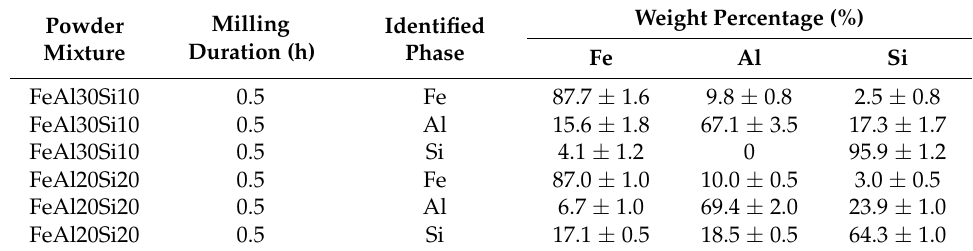
Figure 6. The SEM micrographs of the FeAl20Si20 alloy after: ( a ) 0.5 h, ( b ) 1 h, ( c ) 2 h, ( d ) 4 h of MA. Table 5. Average chemical composition of the phases identified in milled samples by SEM-EDS.